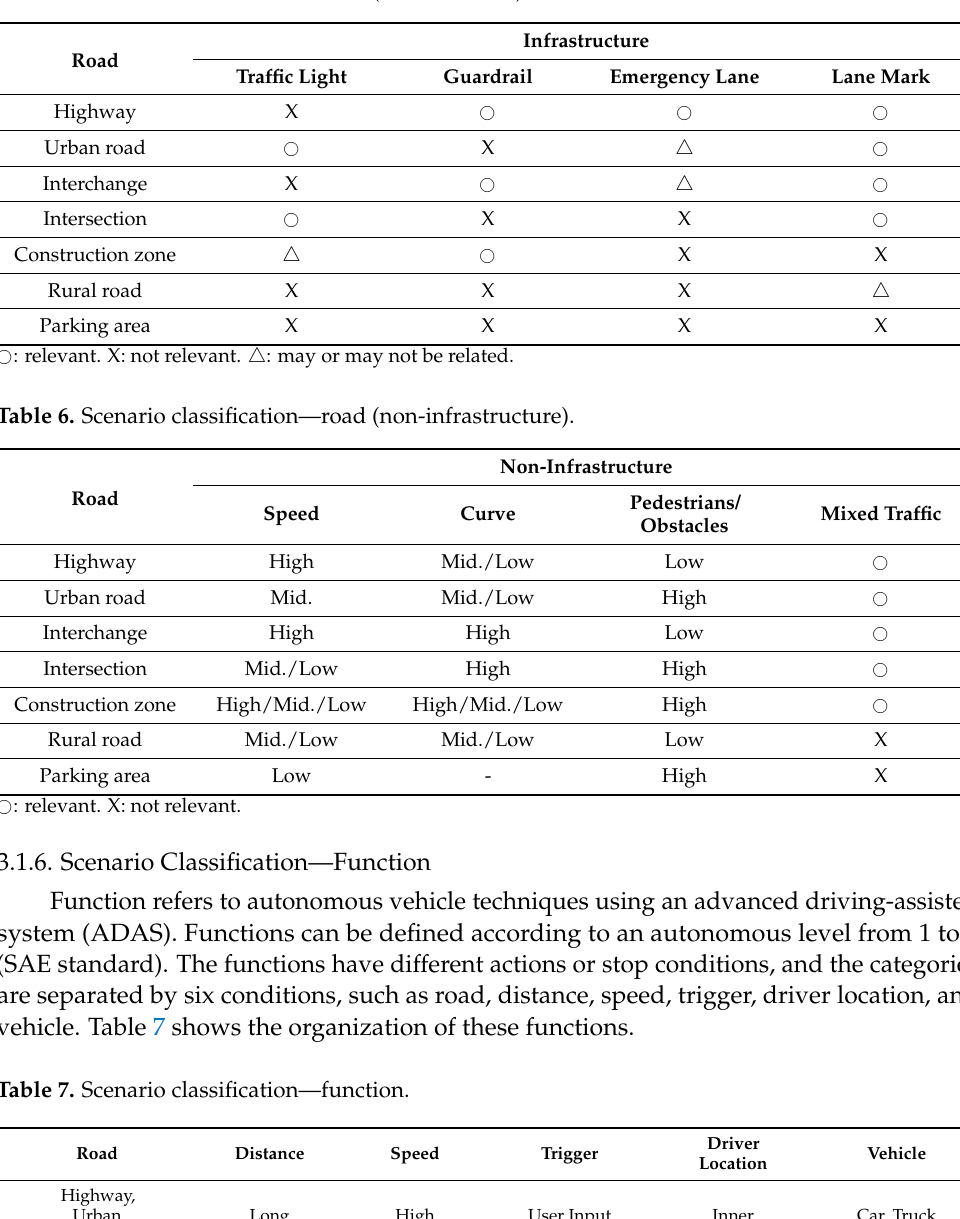
Table 5. Scenario classification—road (infrastructure).